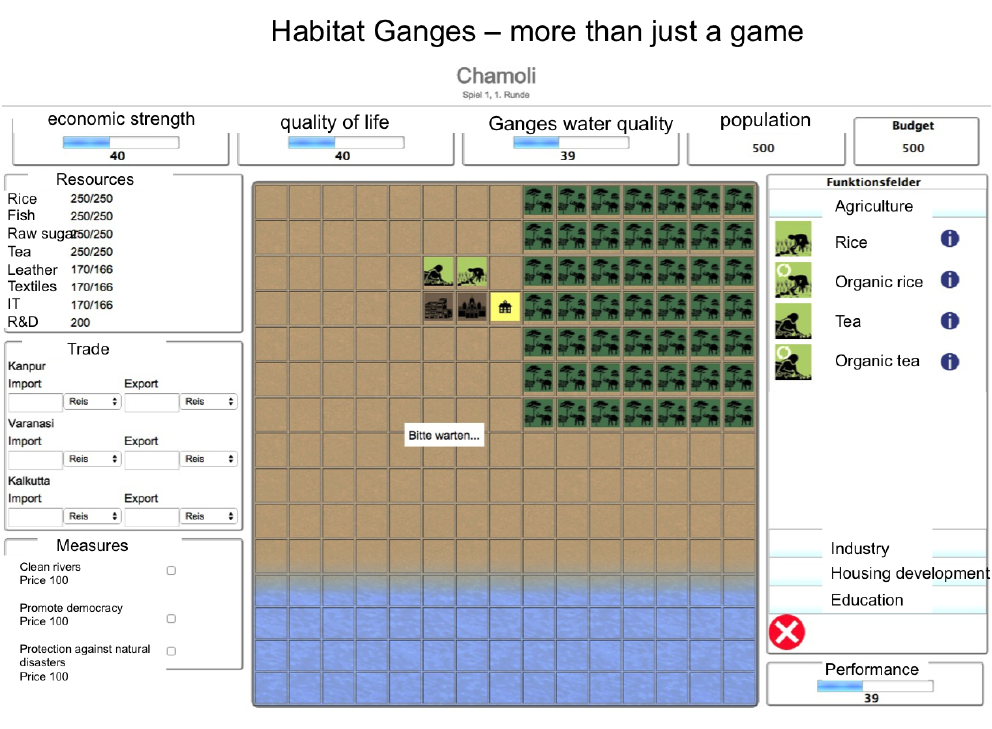
Figure 3. A screenshot of Habitat Ganges – more than just a game (Lebensraum Ganges – Mehr als ein Spiel). Shown is the game interface for the district of Chamoli, translated from the German. Note that the resources here can be related to those shown in the resource price list in Table 2.